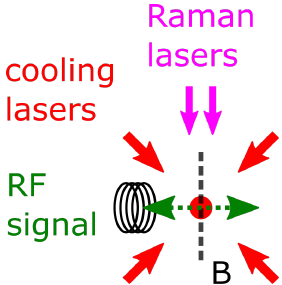
Figure 2. Conceptual setup. Cooling lasers and Raman lasers are pointing to the atom cloud. At the position of the atom cloud, the RF oscillating signal is perpendicular to the bias magnetic field B . Raman lasers are parallel to the B